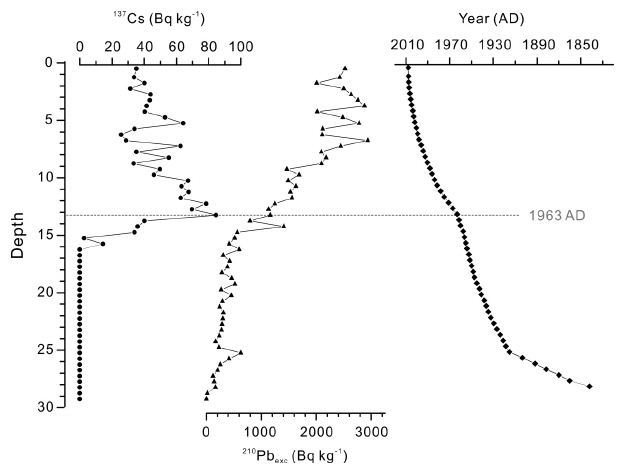
Figure 5. The age and depth model for 210 Pb dating results of the short core (28cm) from Tiancai Lake. The concentration of 137 Cs (circle), excess 210 Pb (triangle) and the calibrated age (AD years) (square) were plotted against core sample depth respectively.